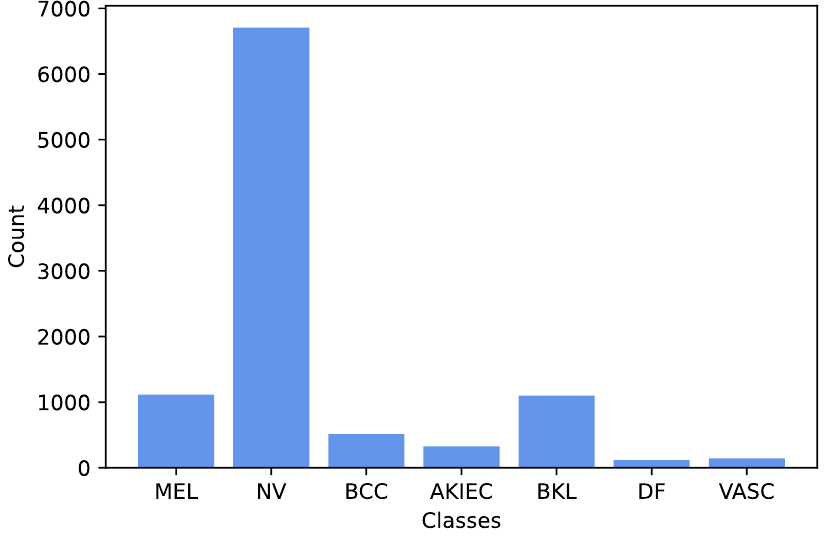
Figure 1. Histogram of the classes in International Skin Imaging Collaboration (ISIC) 2018 dataset. AKIEC = actinic keratosis; BCC = basal cell carcinoma; BKL = benign keratosis lesion; DF = dermatofi- broma; MEL = melanoma; NV = melanocytic nevus; VASC = vascular